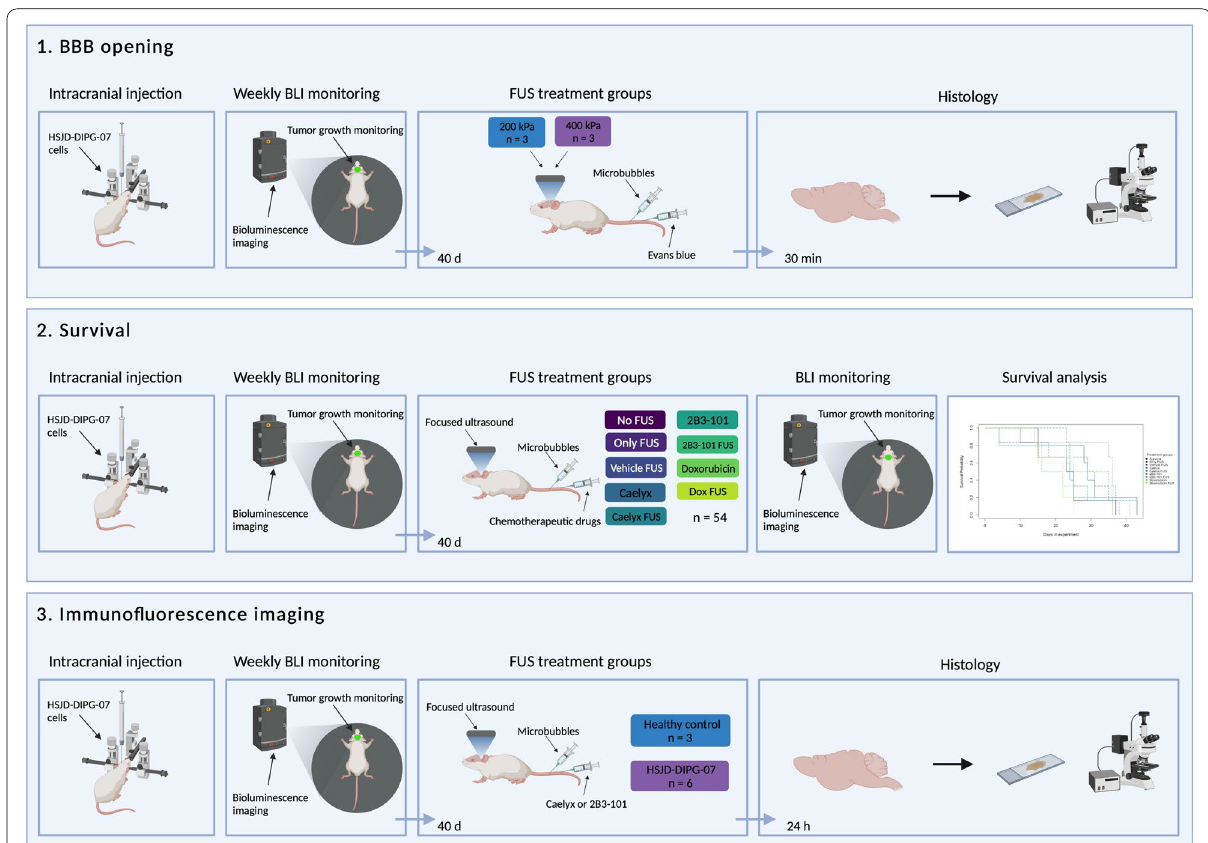
Fig. 1 Experimental design. BBB opening after FUS was determined in HSJD-DIPG-07 tumor-bearing mice which received 200 kPa ( n 3) and = 400 kPa ( n 3) to observe the extent of BBB opening. Mice received 400 kPa during treatment in all subsequent experiments. Survival analysis was = performed on HSJD-DIPG-07 xenograft models ( n 54). Mice were regularly monitored with BLI and upon increase of the signal, mice received = treatment with focused ultrasound. After treatment, mice were monitored and sacrificed at humane endpoints. Immunofluorescence histology was performed on non-tumor bearing mice ( n 3) and tumor bearing mice (HSJD-DIPG-07) ( n 6) to determine the presence of liposomal = = formulations of doxorubicin in the brain parenchyma. At 24 h after treatment mice were sacrificed and brains were frozen until analysis. (Created with